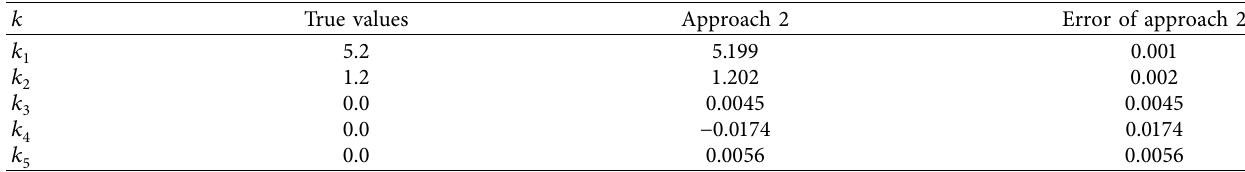
Table 7: Comparison of the true and estimated parameters for Example 4.